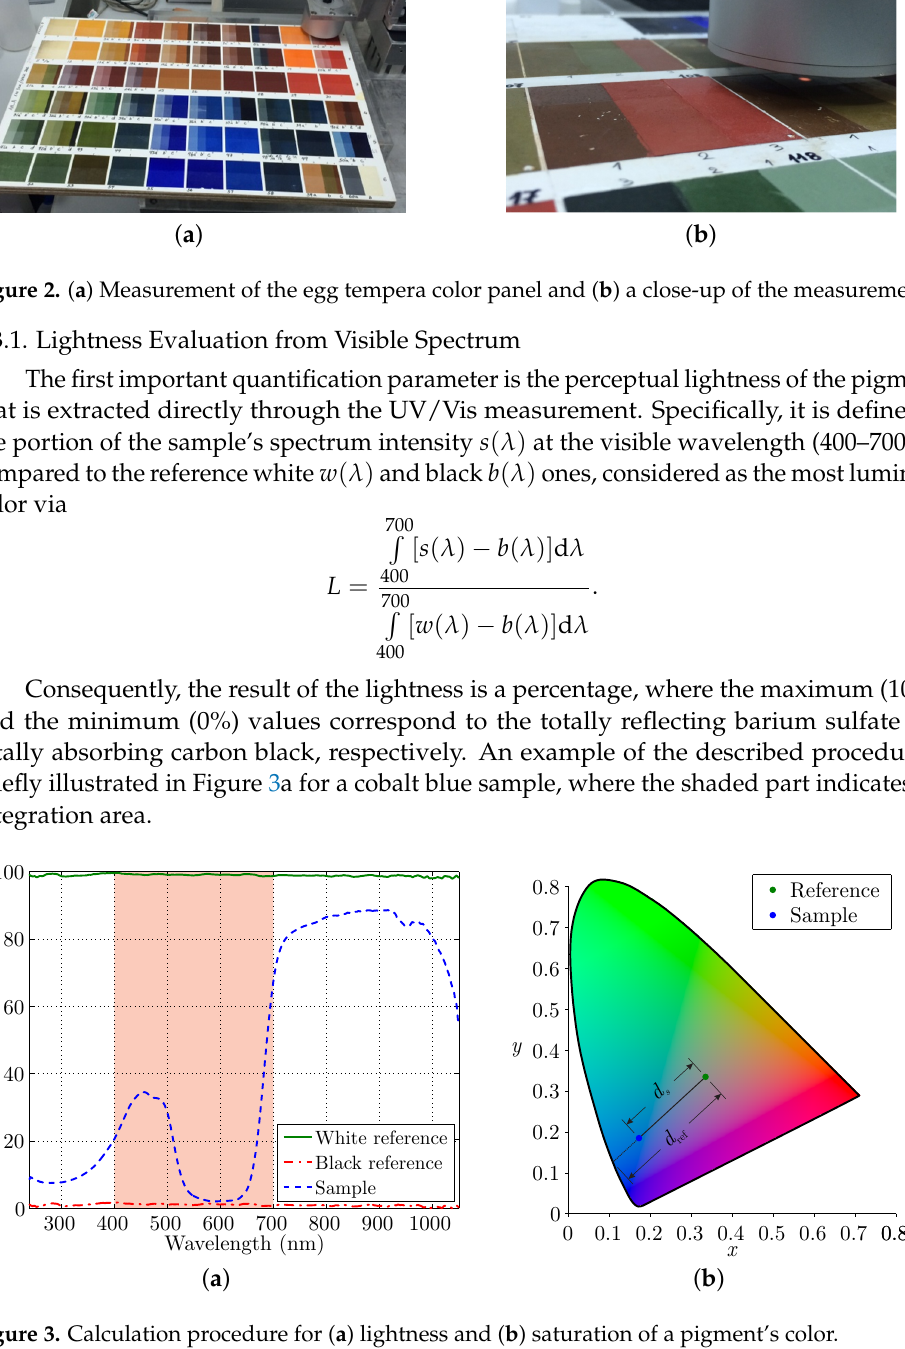
Figure 3. Calculation procedure for ( a ) lightness and ( b ) saturation of a pigment’s